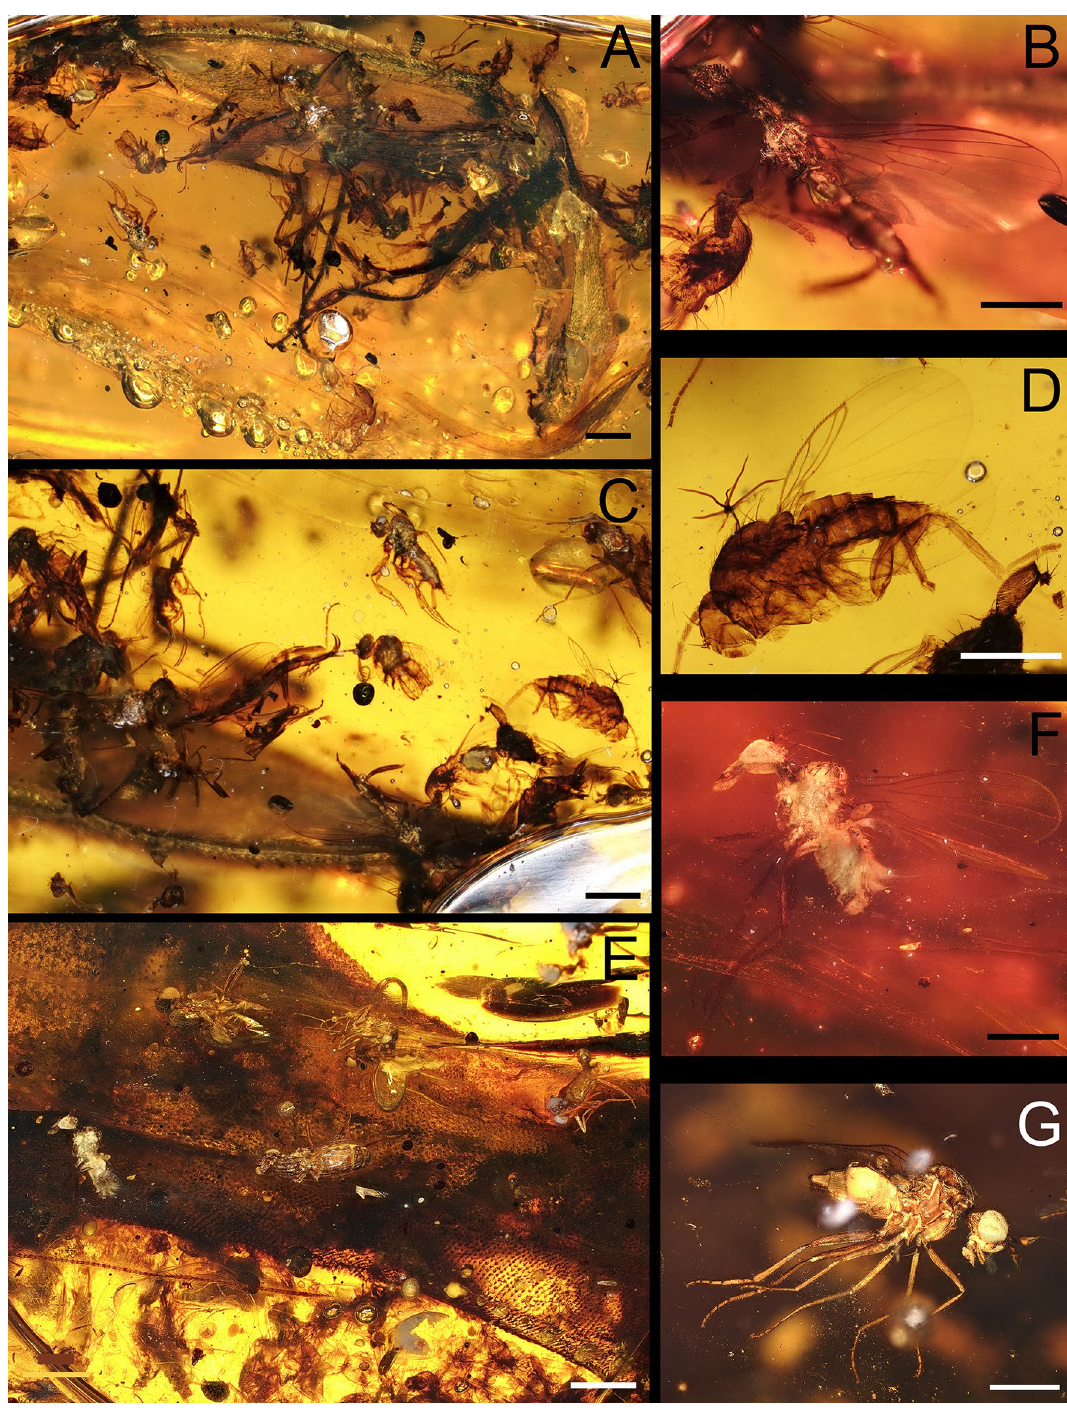
Figure 3. Syninclusions s.l. in piece GRS-Ref-28627 being the most relevant the holotype of Oculudentavis naga and the beetle, most likely an Elateroidea. ( A ) Elateroid beetle. ( B ) Empidoid fly morphotype 1. ( C ) Group of flies as eusyninclusions with the Elateroidea beetle. ( D ) Phorid fly. ( E ) Group of flies as eusyninclusions with O. naga . ( F ) Empidoid fly morphotype 2. ( G ) Empidoid fly morphotype 3. Scale bars: ( A , C , and E ) 1 mm, ( B , D , F , and G ) 0.5